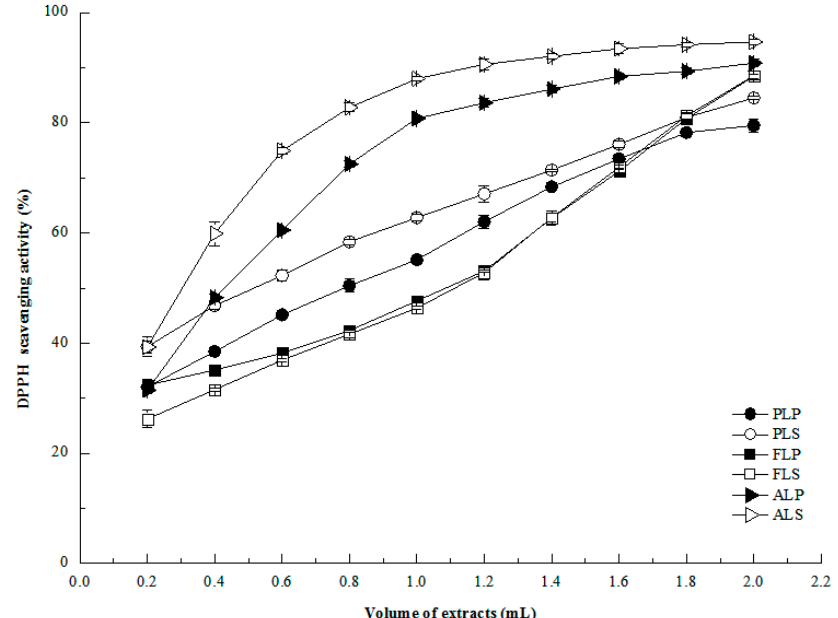
Figure 2. DPPH radical scavenging activities of longan byproducts. PLP: phenolic in longan pericarp, PLS: phenolic in longan seed, FLP: flavonoid in longan pericarp, FLS: flavonoid in longan seed, ALP: alkaloid in longan pericarp, and ALS: alkaloid in longan seed. Phenolics in longan pericarp and seed were diluted 2 times, flavonoids in longan pericarp and seed were diluted five times, and alkanoids in longan pericarp and seed were diluted 100 times.